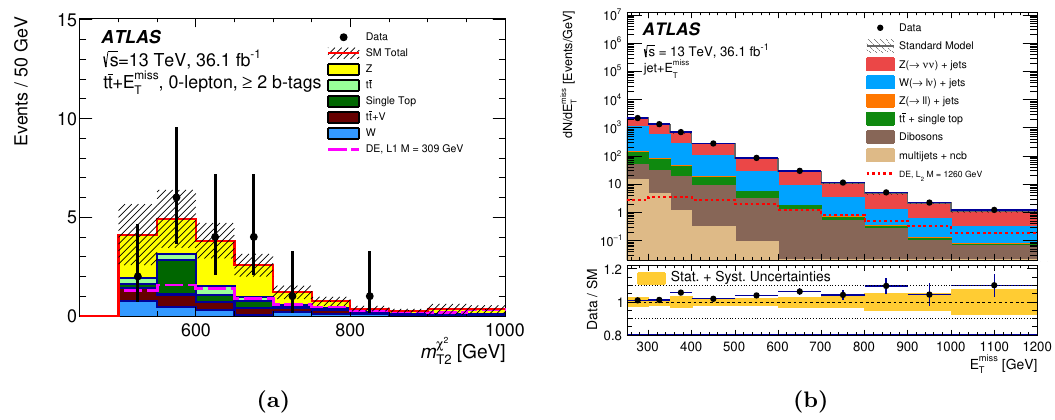
Figure 9. Observed m (cid:31) 2 and E miss distributions in the (a) t (cid:22) t (0 L ) + E miss T T2 analyses, respectively, compared with a representative DE signal and the post-(cid:12)t background pre- dictions. The error bands show the total statistical and systematic uncertainties of the background predictions. Representative DE signal distributions are shown for (b),